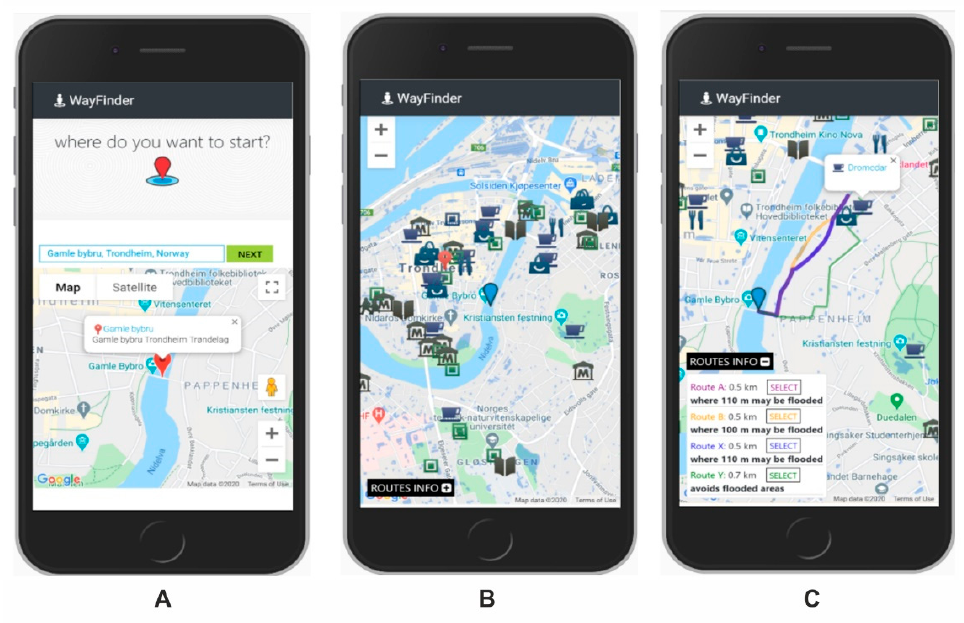
Figure 2. A sequence of screenshots of the WayFinder tool demonstrating how pedestrians use the tool to search for route suggestions. First, the user’s geographic position is specified (screenshot ( A )). Next, the user selects one of displayed map symbols of the objects serving as alternate endpoints of walks (screenshot ( B )). In response, WayFinder provides four alternative route suggestions (screenshot ( C )).